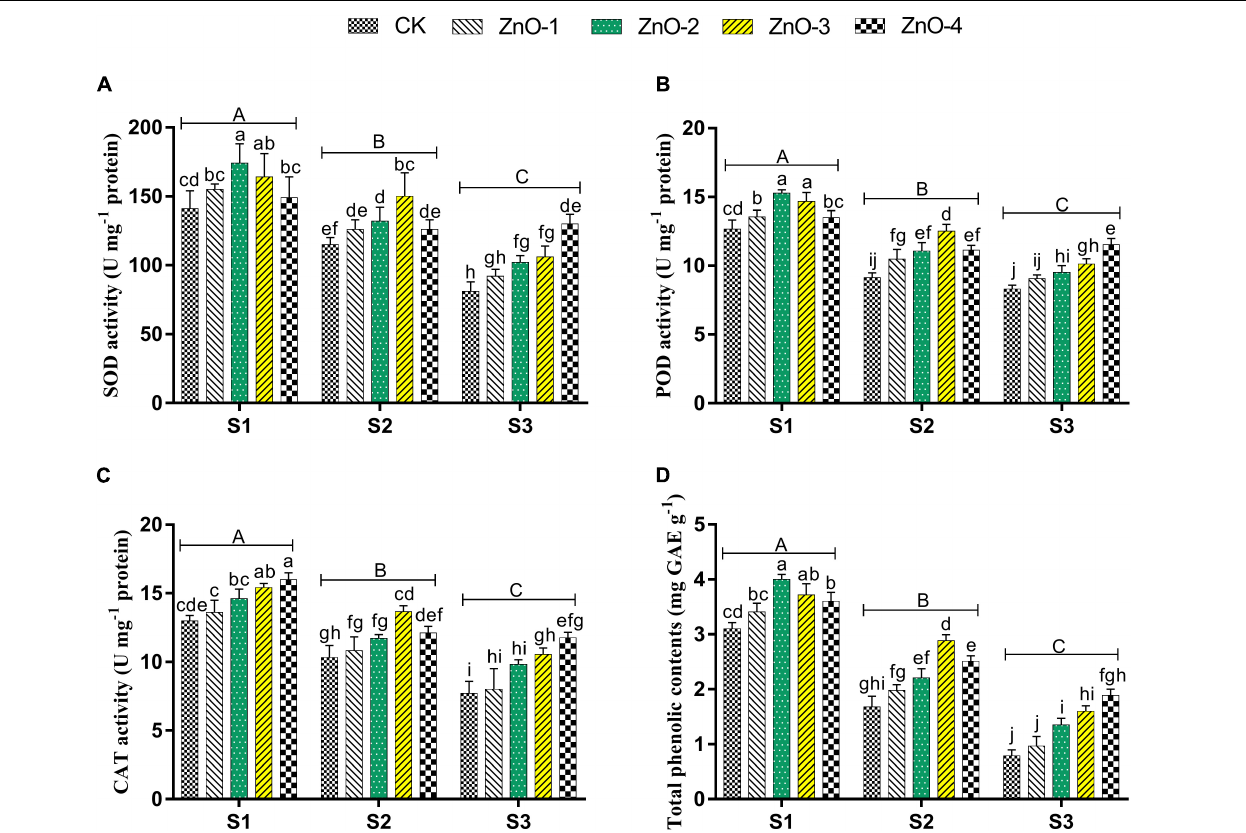
FIGURE 3 | Effect of foliar application of nano-ZnO on superoxide dismutase (SOD) (A) , peroxidase (POD) (B) , catalase (CAT) (C) , total phenolic contents, and (D) in Vigna radiata L. under sowing time generated heat stress. Nano-ZnO doses: CK (distilled water), ZnO-1 (15 mg l − 1 ), ZnO-2 (30 mg l − 1 ), ZnO-3 (45 mg l − 1 ), and ZnO-4 (60 mg l − 1 ). S1, First sowing-March 1 (recommended); S2, Second sowing-March 22 (late sown); S3, Third sowing-April 11 (late sown). Data are mean ( ± SE) of three replicates and different letters designate significant changes at Tukey’s test ( p < 0.05). In contrast, capital letters represent a significant difference among sowing time treatments and small letters represent a significant difference among the nano-ZnO